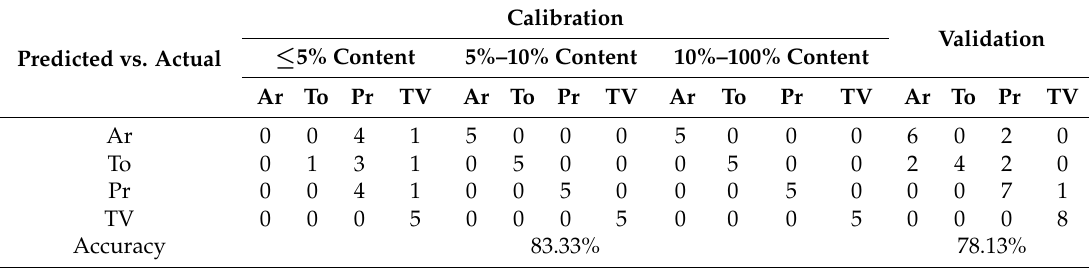
Table 4. Classified results of four soy categories using SVM with FT-NIRS models.